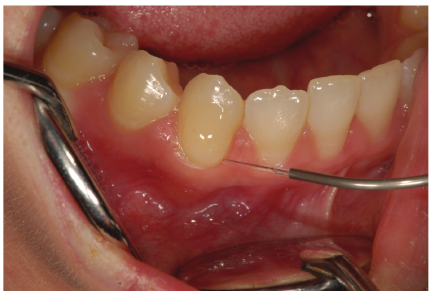
Figure 4: GaAlAs laser application (Group 2).